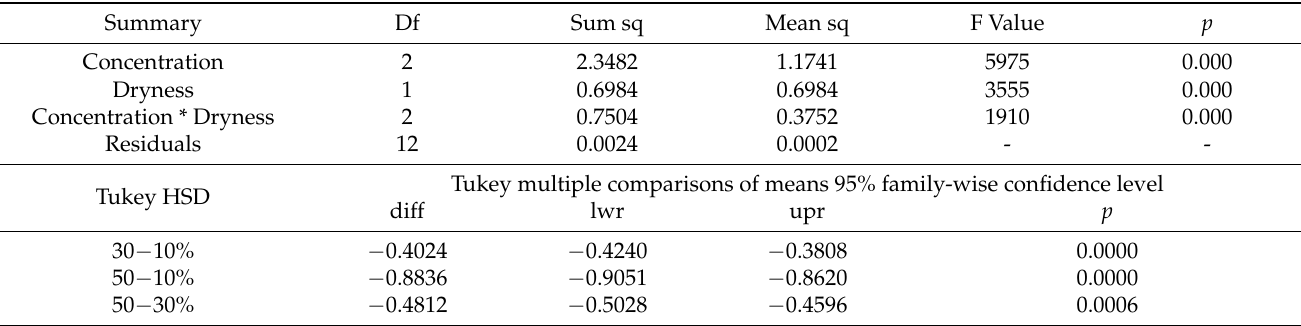
Table 13. Summary of factor importance and Tukey HSD results (KL).